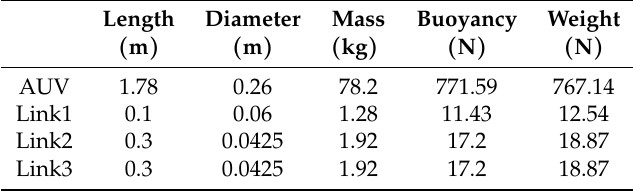
Table 4. The list of UVMS parameters.